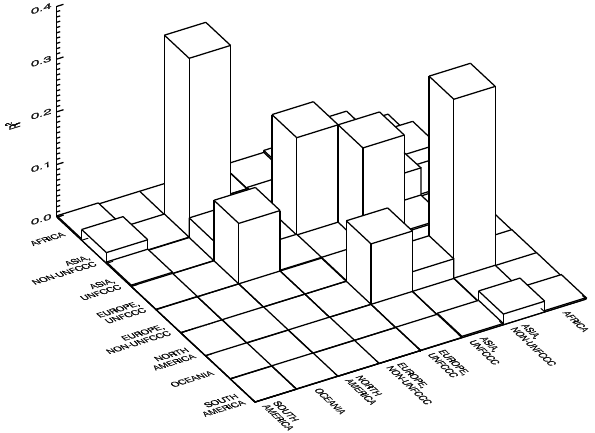
Fig. 5. Average correlations ( R 2 ) between optimized emissions from the eight regions, 2004–2008. Diagonal elements (identically equal to 1) are set to zero for